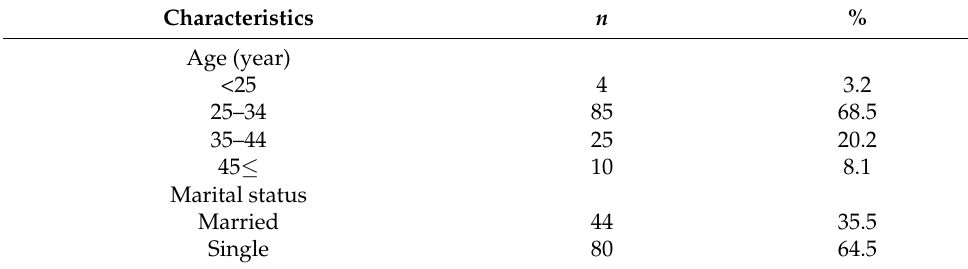
Table 1. General characteristics of the study